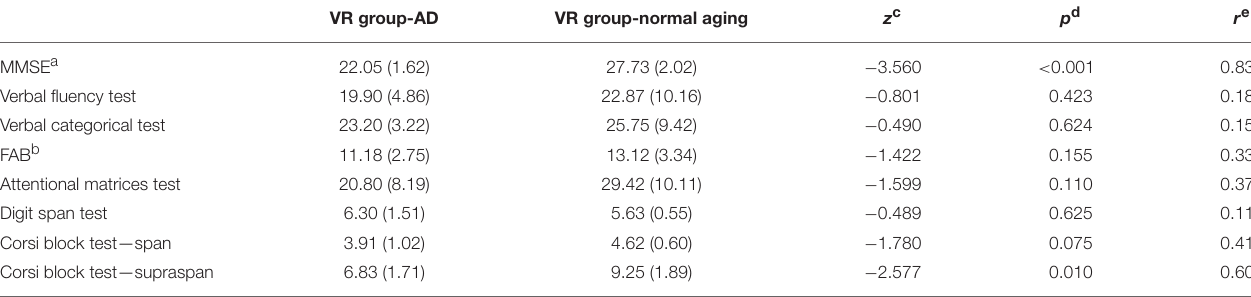
TABLE 4 | Baseline